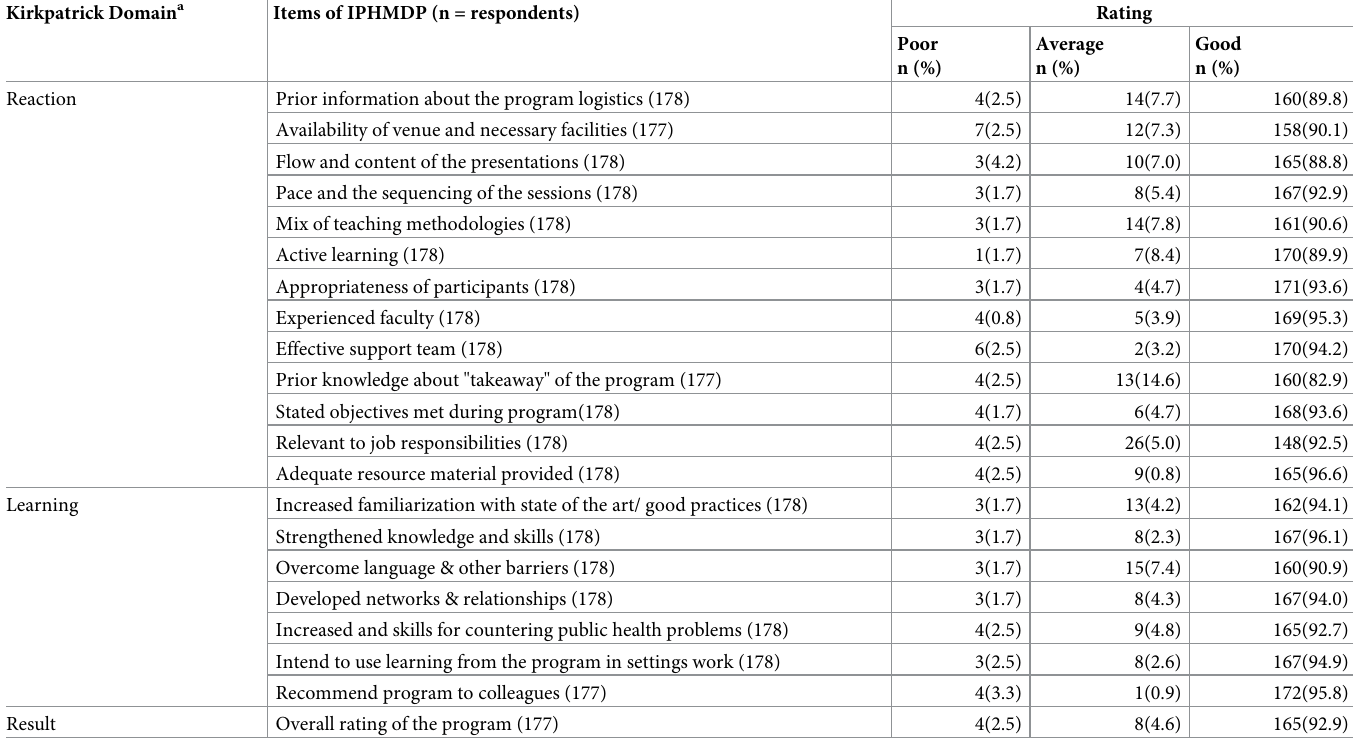
Table 3. Evaluation of various items of IPHMDP based of Kirkpatrick evaluation model. Kirkpatrick Domain